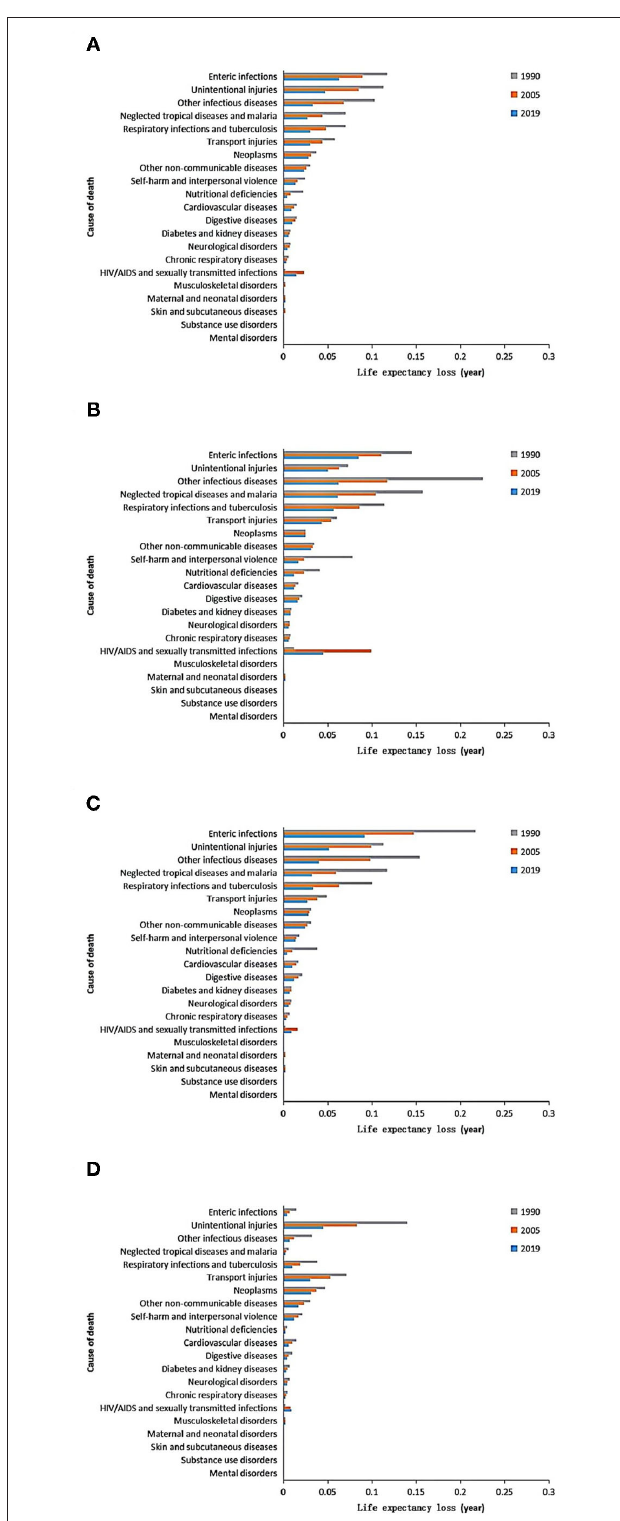
FIGURE 3 | Cause-specific changes of life expectancy (LE) loss in children aged 5–14 years globally (A) and in low-income countries (B) , lower middle-income countries (C) , and upper middle-income countries (D) from 1990 to